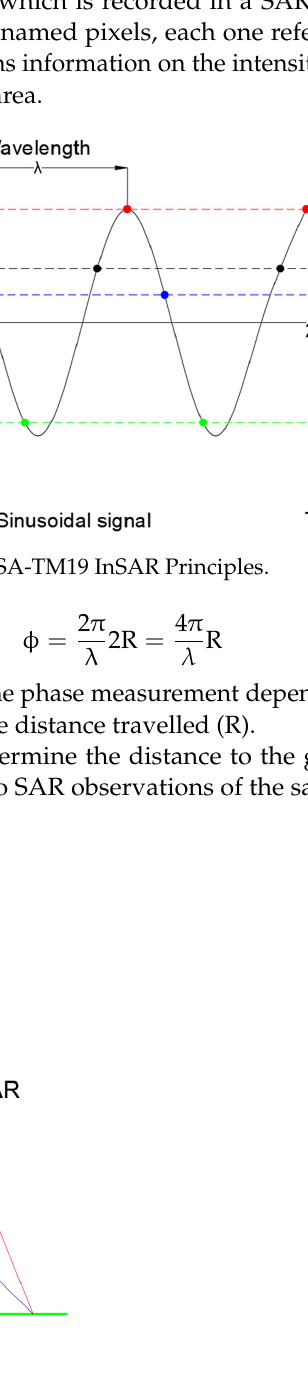
Figure 4. Satellite positions and calculation of the phase difference. Source: ESA-TOPS Interferometry Tutorial.